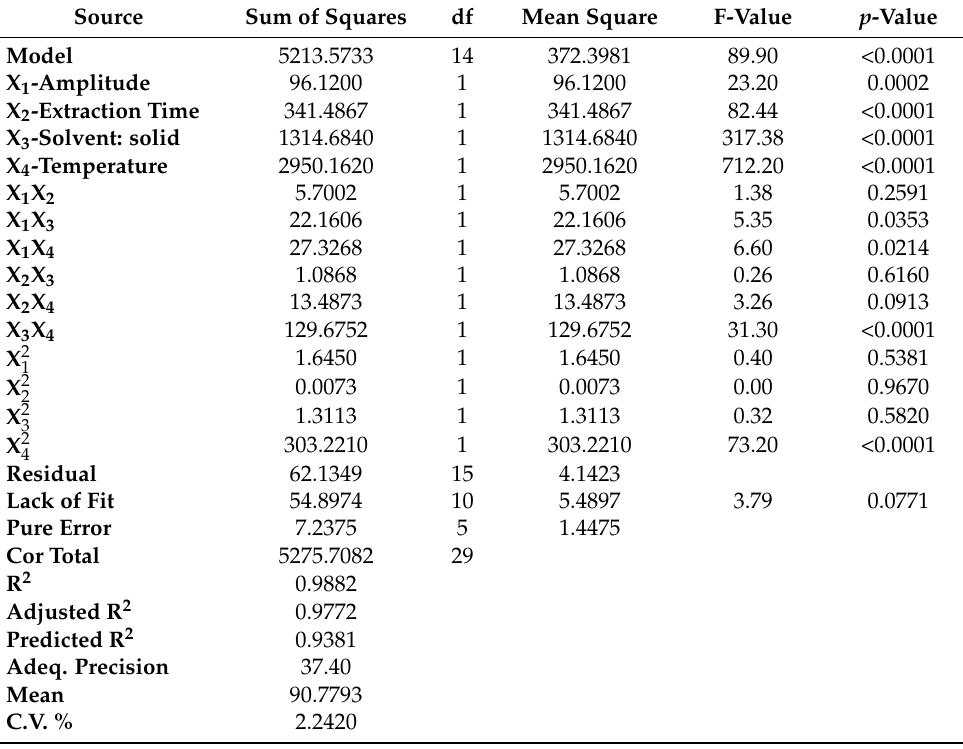
Table 2. Analysis of Variance (ANOVA), factors, and their interaction